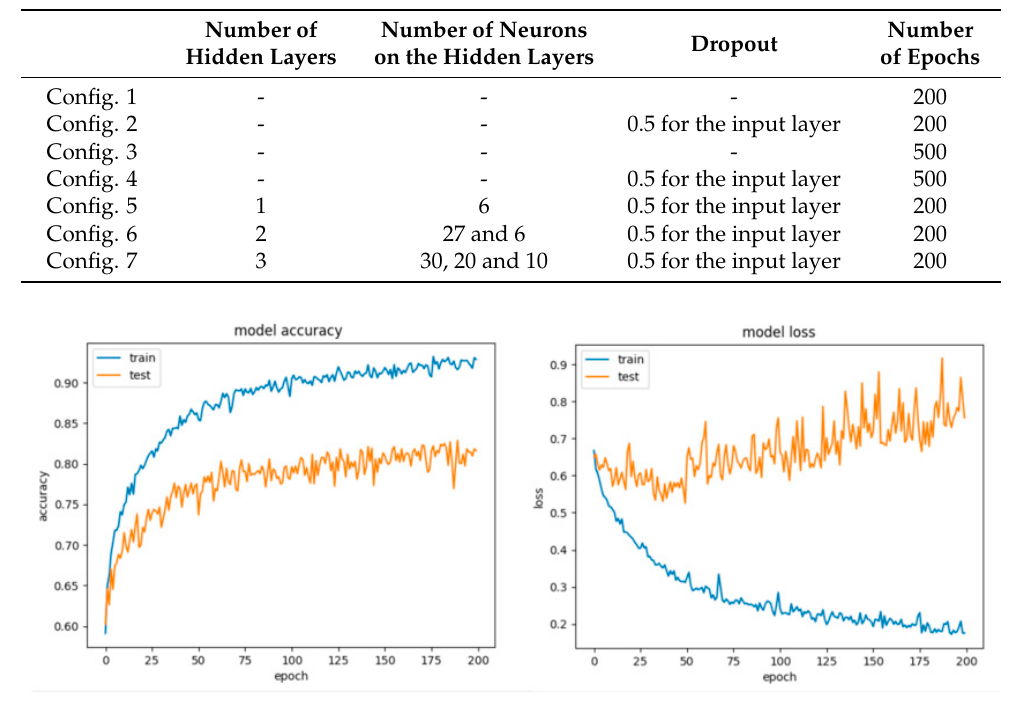
Figure 23. Accuracy and loss for Configuration 1, overlapping dataset.